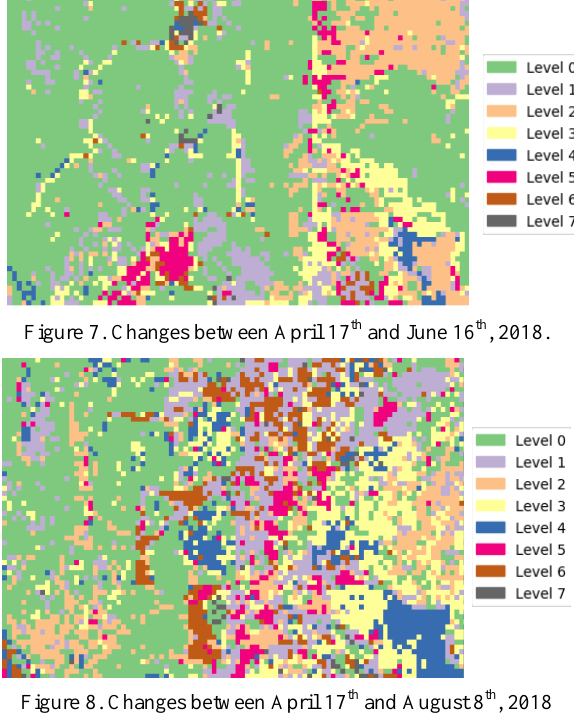
Figure 8. Changes between April 17 th and August 8 th , 2018